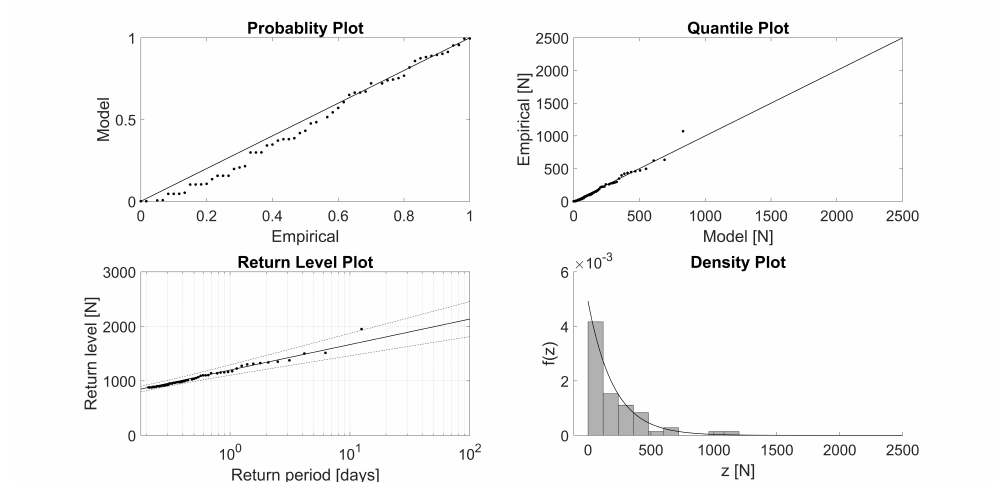
Figure 10. Diagnostic plots for ED fit to the force data with the threshold of 880 N and run time of 0.0134 h. In the return level plot, the dashed lines show the lower and upper bound of the 95% confidence interval. In the density plot, z corresponds to maximum force of each cluster of exceedances.